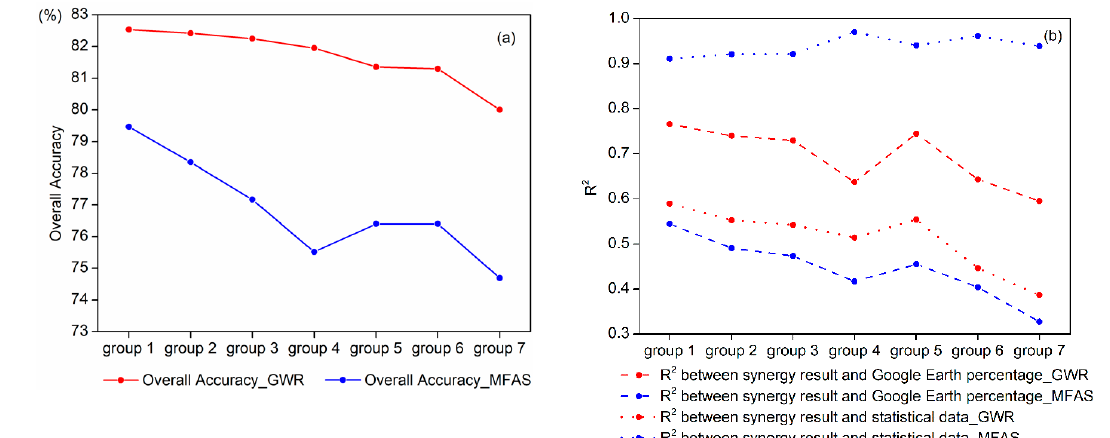
Figure 6. Performance assessment and comparisons including spatial accuracy ( a ), consistency with cropland percentage, and consistency with statistics using input satellite-based map combinations of various average accuracy ( b ).